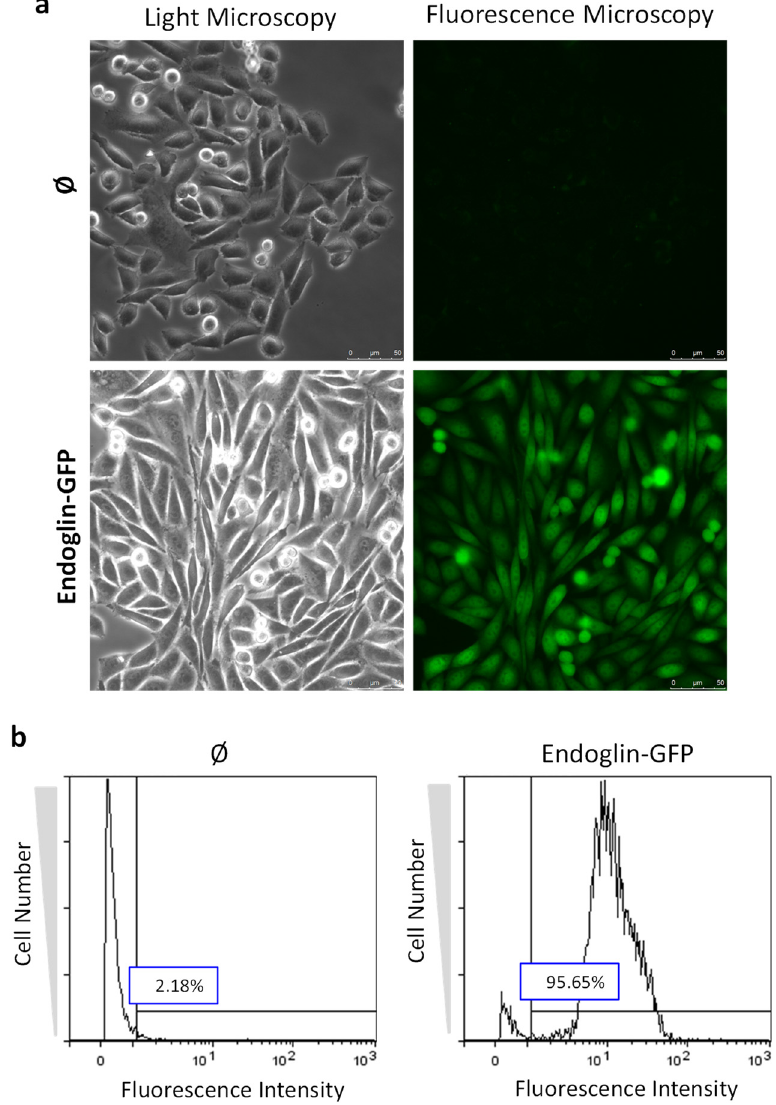
Figure 3. Fluorescence characterization of cell transfectants expressing endoglin–GFP fusion protein. CHO-K1 cells stably transfected with pEGFP–N1/Eng.EC (Endoglin-GFP) or an empty vector (Ø) were analyzed by ( a ) fluorescence microscopy or ( b ) flow cytometry. ( a ) Cells were seeded and cultured on 35 mm glass bottom dishes. After removing media and washing with PBS, cells were observed under fluorescence and light microscopy using a multidimensional microscope (System Leica AF6000 LX, Leica Microsystems, Wetzlar, Germany) at 40x magnification. ( b ) Cells were trypsinized, washed, and resuspended in PBS. Cell fluorescence was analyzed with a Coulter EPICS-XL flow cytometer using logarithmic amplifiers. Vertical line represents the gate determined by the intensity corresponding to the empty vector (Ø). Percentage of positive cells indicated by the horizontal bar.